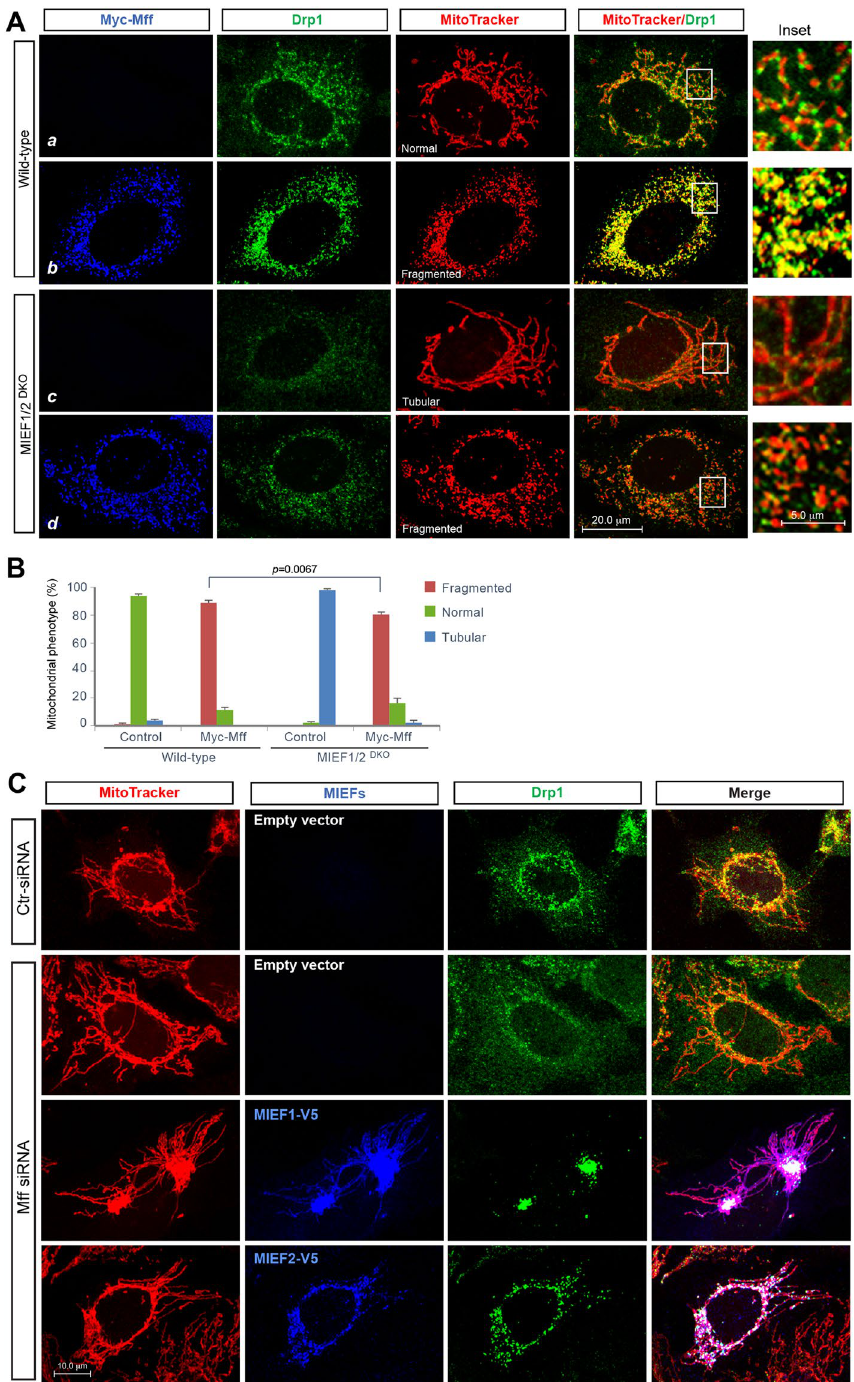
Figure 2. Ablation of MIEF1/2 impairs Mff-induced accumulation of Drp1 on mitochondria, whereas knockdown of Mff does not impair MIEF-mediated recruitment of Drp1 to mitochondria. ( A ) Confocal images of mitochondrial morphology and Drp1 distribution in wild-type and MIEF1/2 DKO 293T cells transfected with empty vector or Myc-Mff plasmid. Cells were stained with MitoTracker (red) followed by immunostaining with anti-Drp1 (green) and anti-Myc (blue) antibodies. Insets represent high magnification views of the boxed areas. Quantitative co-localization of Drp1 with mitochondria is summarized in Fig. 3D. ( B ) Percentages (mean ± SEM) of cells with indicated mitochondrial morphologies in wild-type and MIEF1/2 DKO 293T cells transfected with empty vector or Myc-Mff plasmid in three independent experiments ( ≥ 150 cells were analyzed per experiment). ( C ) Knockdown of Mff does not affect MIEF-mediated recruitment of Drp1 to mitochondria. Confocal images show Drp1 distribution on mitochondria and in the cytoplasm. 293T cells were treated with control siRNA, or Mff siRNA, followed by transfection with either empty vector or with MIEF1-V5 or MIEF2-V5 as indicated, and stained with MitoTracker (red), anti-Drp1 (green) and anti-V5 (blue)